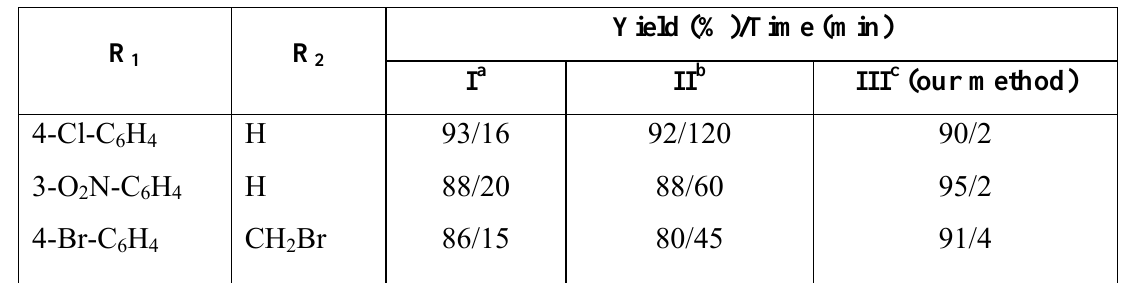
Table2. Comparison of deprotection of 1,3(cid:150)dithanes by our method with some of those reported in the